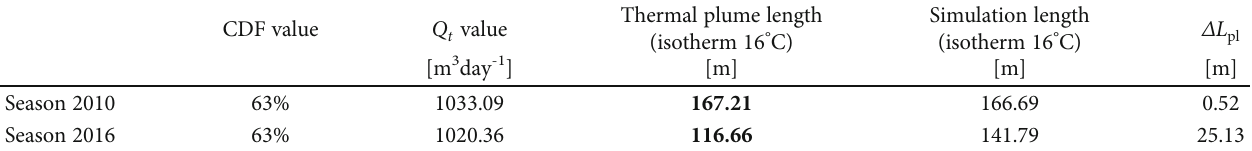
Table 6: Detailed results of plume length evaluated by fi xing CDF equal to 63%. CDF value Q t